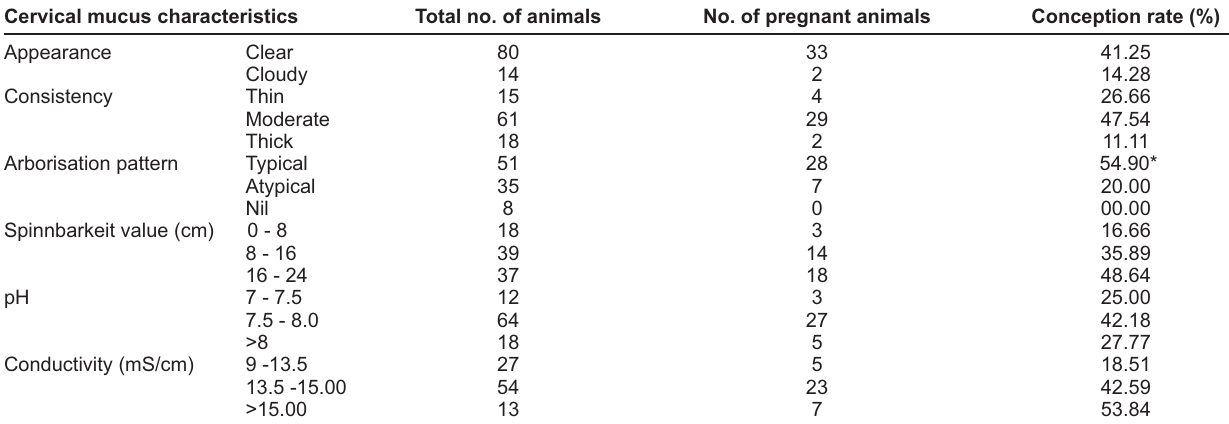
Table-1: Conception rate in various classes of cervical mucus in Murrah buffaloes (n=94) during periestrual period Cervical mucus